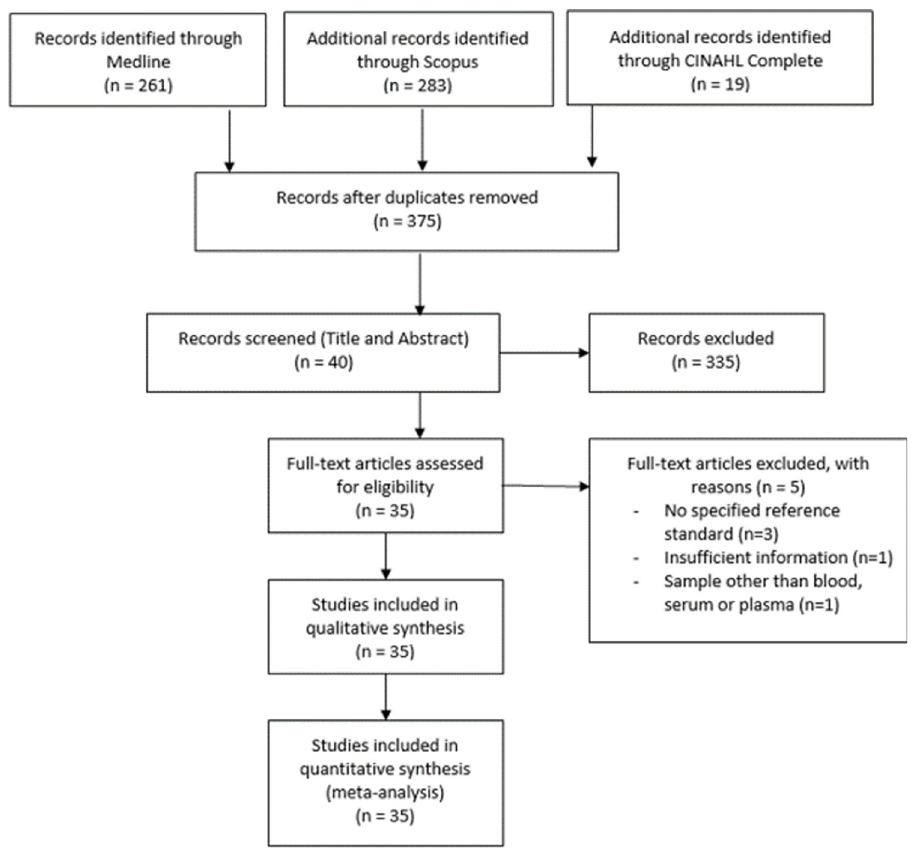
Fig 1. PRISMA flow